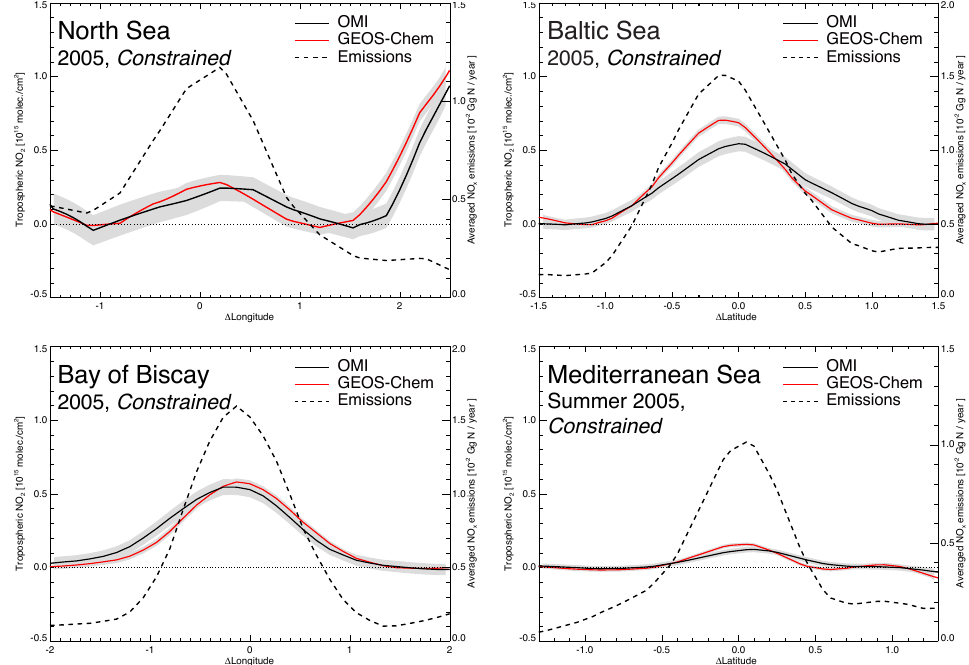
Fig. 10. Along-ship-track averages of the tropospheric NO 2 columns over the areas in Fig. 6c for observed columns by OMI (black line), and simulated columns by GEOS-Chem (red line) using constrained emissions of Fig. 9b. OMI tropospheric NO 2 columns were retrieved using a priori NO 2 profiles simulated with the new top-down emissions (see Fig. S1 and S2). Emissions averaged along the ship track are represented by the dashed line. The area was averaged over longitude for the Baltic Sea and the Mediterranean Sea (upper and bottom right) and over latitude for the North Sea and the Bay of Biscay (upper and lower left). A linear background fit was subtracted from the averages (see Fig. S3), and grey shading represents the sample standard